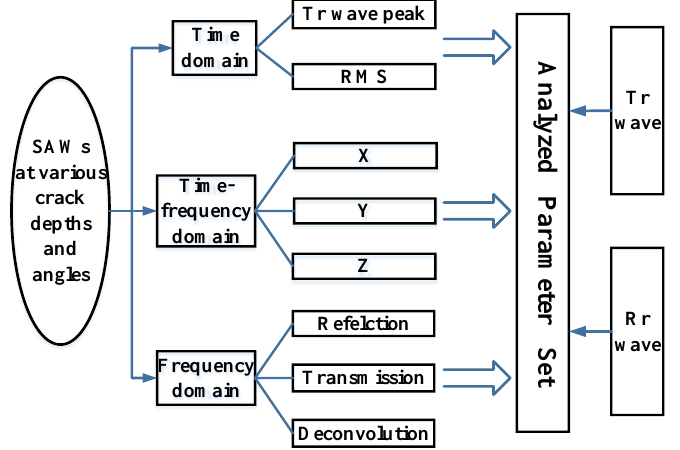
Figure 6. Feature extraction flowchart. X: WP coefficient peak; Y: WP energy peak; Z: WP entropy.